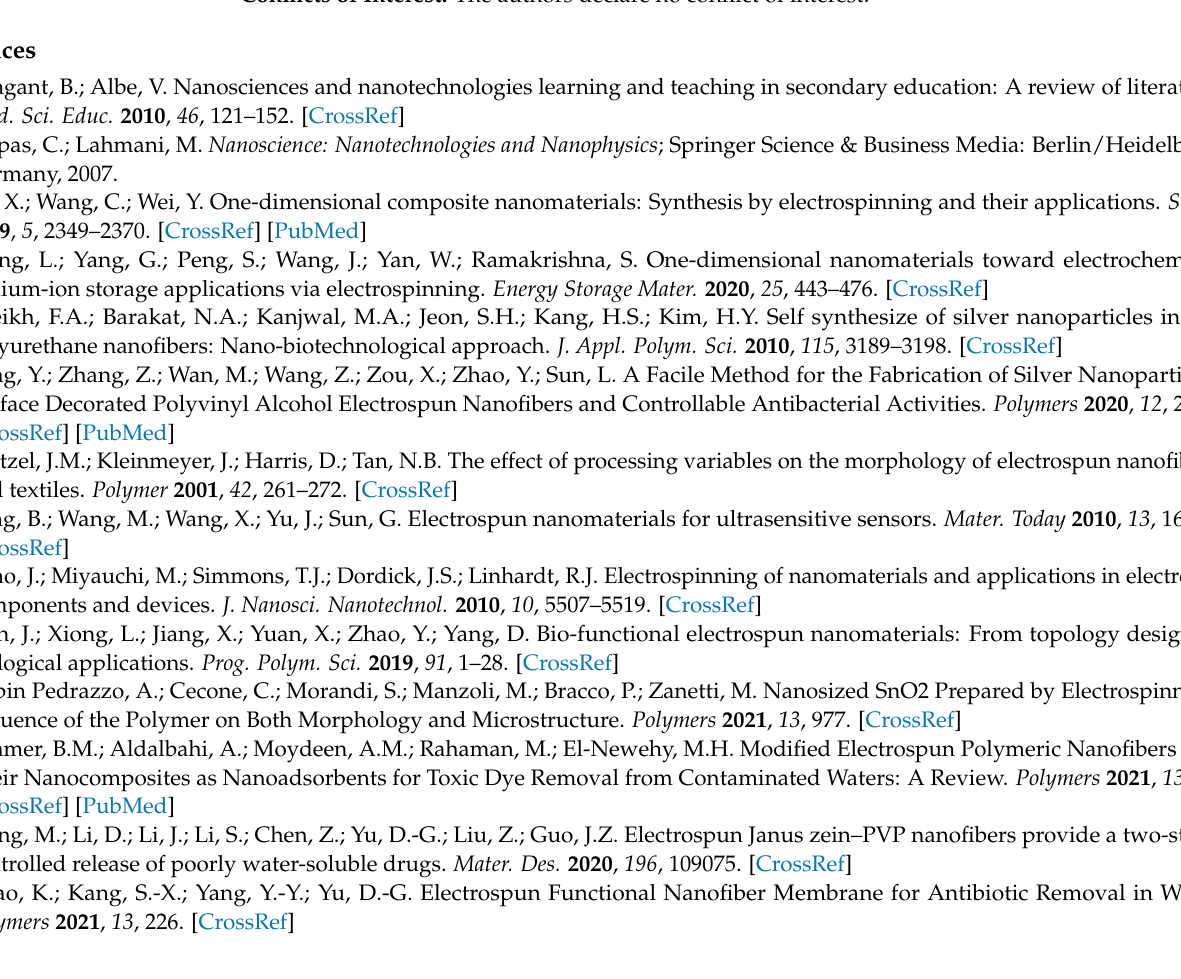
XRD pattern of Ag NPs. Figure S5: FTIR spectra of the Ag NPs. Figure S6: SEM images and Segmented images of PVA control (A), PVA-Ag 2% (B), PVA-Ag 4% (C), TPU control (D), TPU-Ag 2% (E), and TPU-Ag 4%